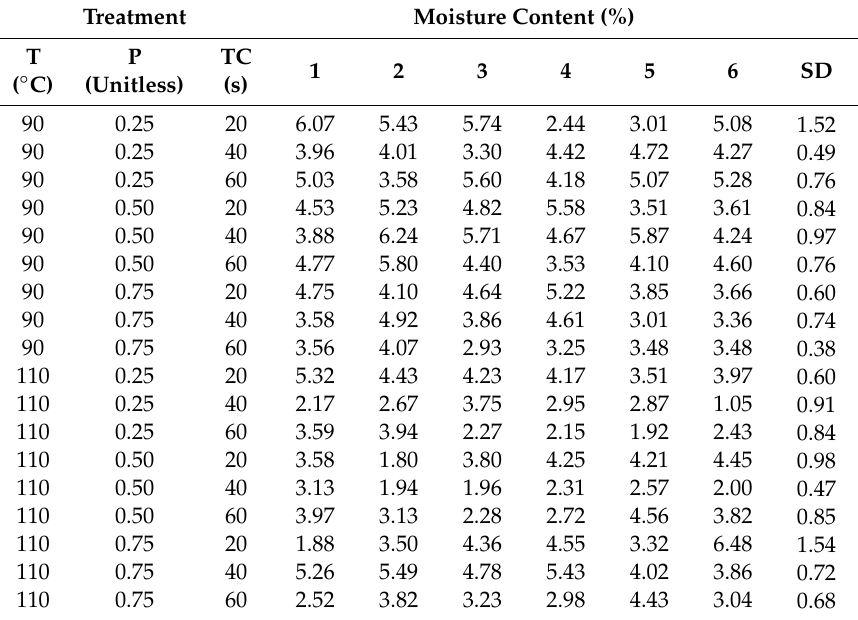
Table 12. Results for moisture content in rice husk and pine sawdust